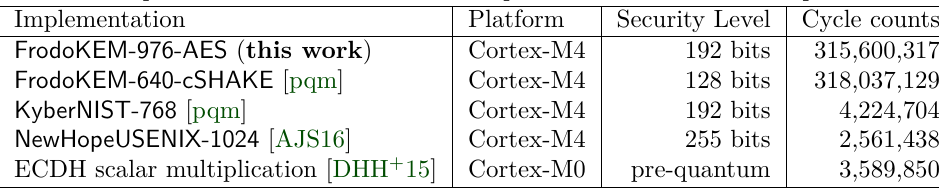
Table 7: Comparison of our microcontroller implementation with other implementations.